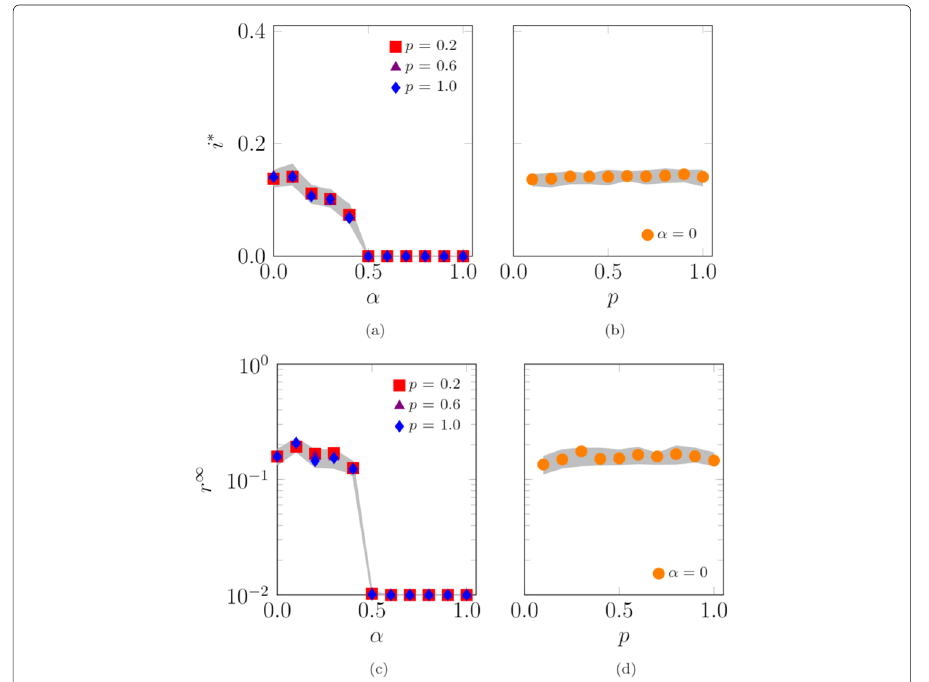
Fig. 9 Influence of the agents’ randomness, α , and the probability of jumping outside the location, p , on the endemic prevalence (SIS model), a – b , and the epidemic size (SIR model), c – d . Curves represent the median of 100 independent simulations; 95% confidence bands are displayed in gray. Agents are initially inside their base location and the infection starts after 100 steps to allow the agents to reach a steady-state configuration. The fraction of randomly chosen initial infected is 0.01. Other parameter values are L = 100, N = 10,000, D = 10 9 , (cid:6) min = 100, (cid:6) max = 10,000, σ min = 1, σ max = 1,000, v = 500, c = 4 · 10 − 4 , ω = 2.4, γ = 2.1, λ = 0.15, and μ =